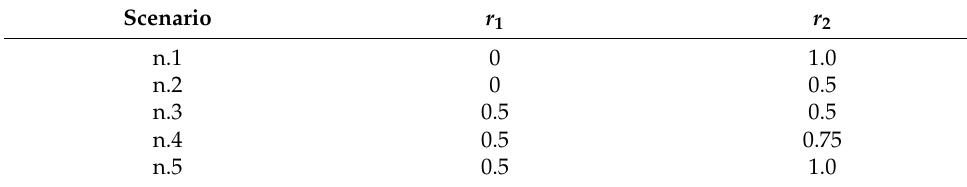
Table 1. Various